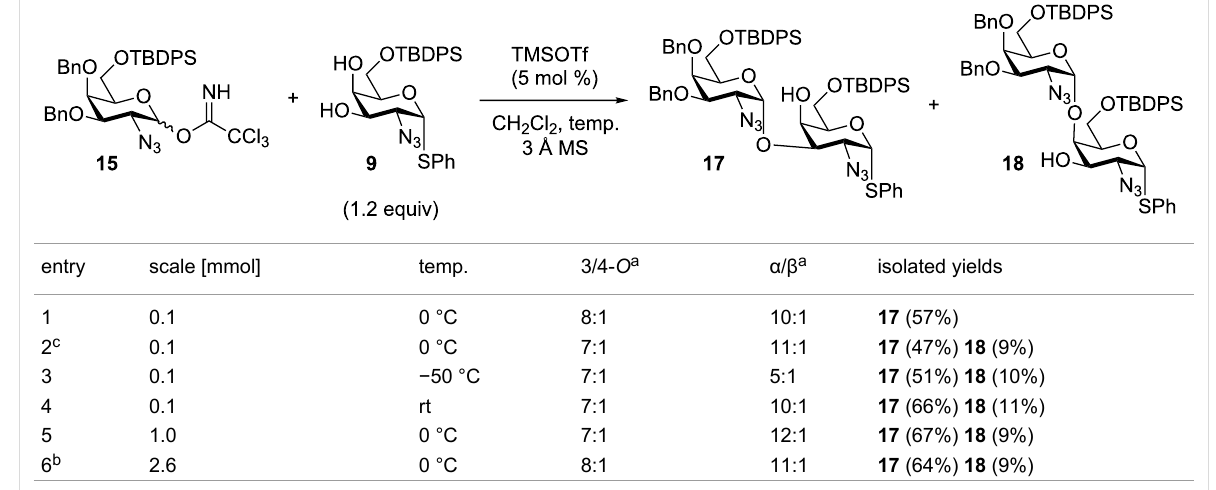
Table 1: Optimizing the α ,3- O -selective glycosylation conditions.